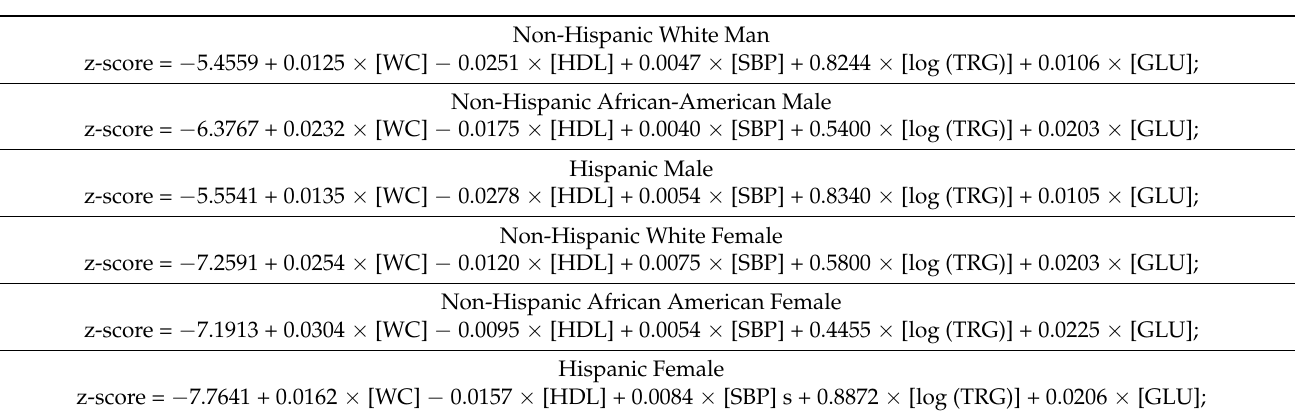
Table 1. Formulas utilized to calculate metabolic syndrome severity scores (MSSS) (z-score) for adult